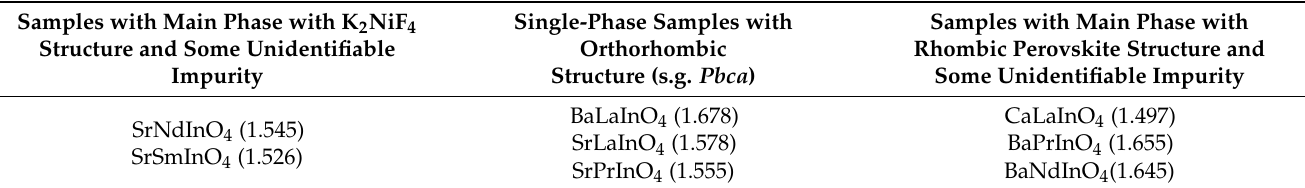
Table 1. Some compositions with layered perovskite structure, obtained by Titiov et al. [86], the cation size ratio is indicated in brackets.